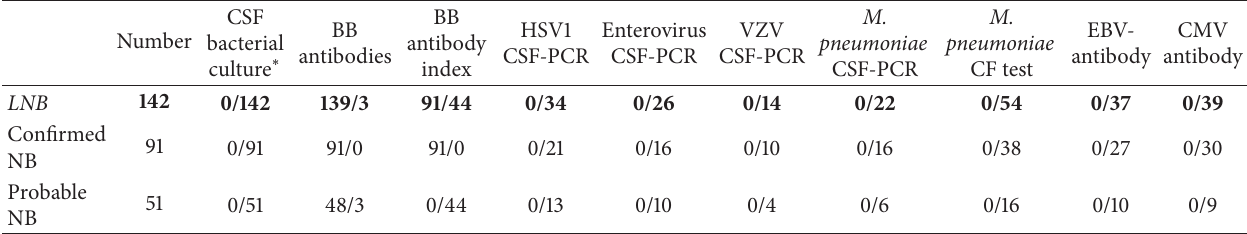
Table 1: Numbers of positive and negative microbiological tests in 142 children with Lyme neuroborreliosis.